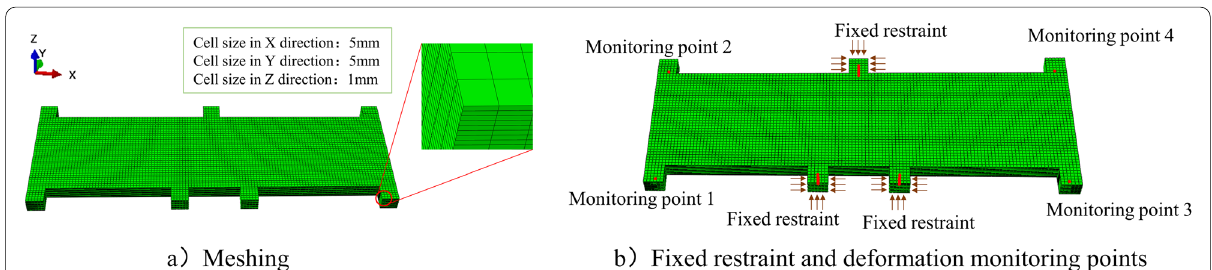
Fig. 7 Machining parameters and finite element settings